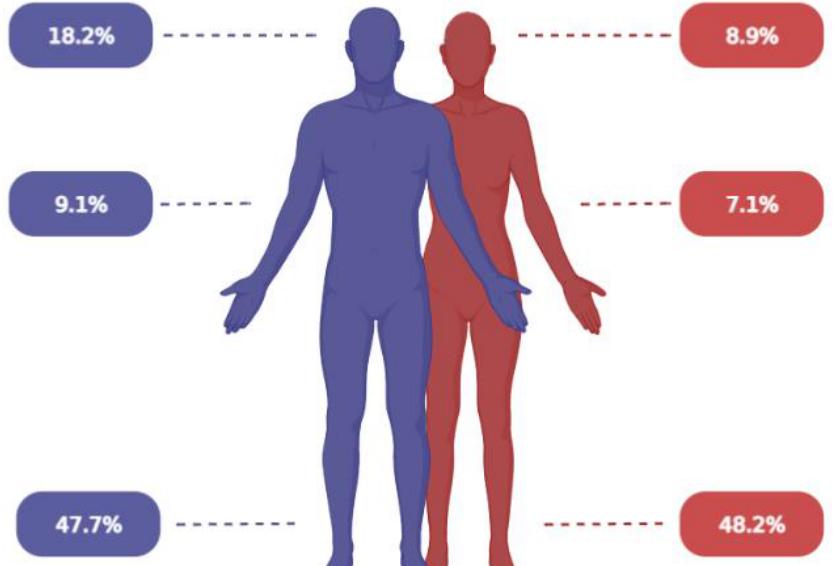
Figure 1. Illustration of injury region between genders. Figures created with BioRender.com.